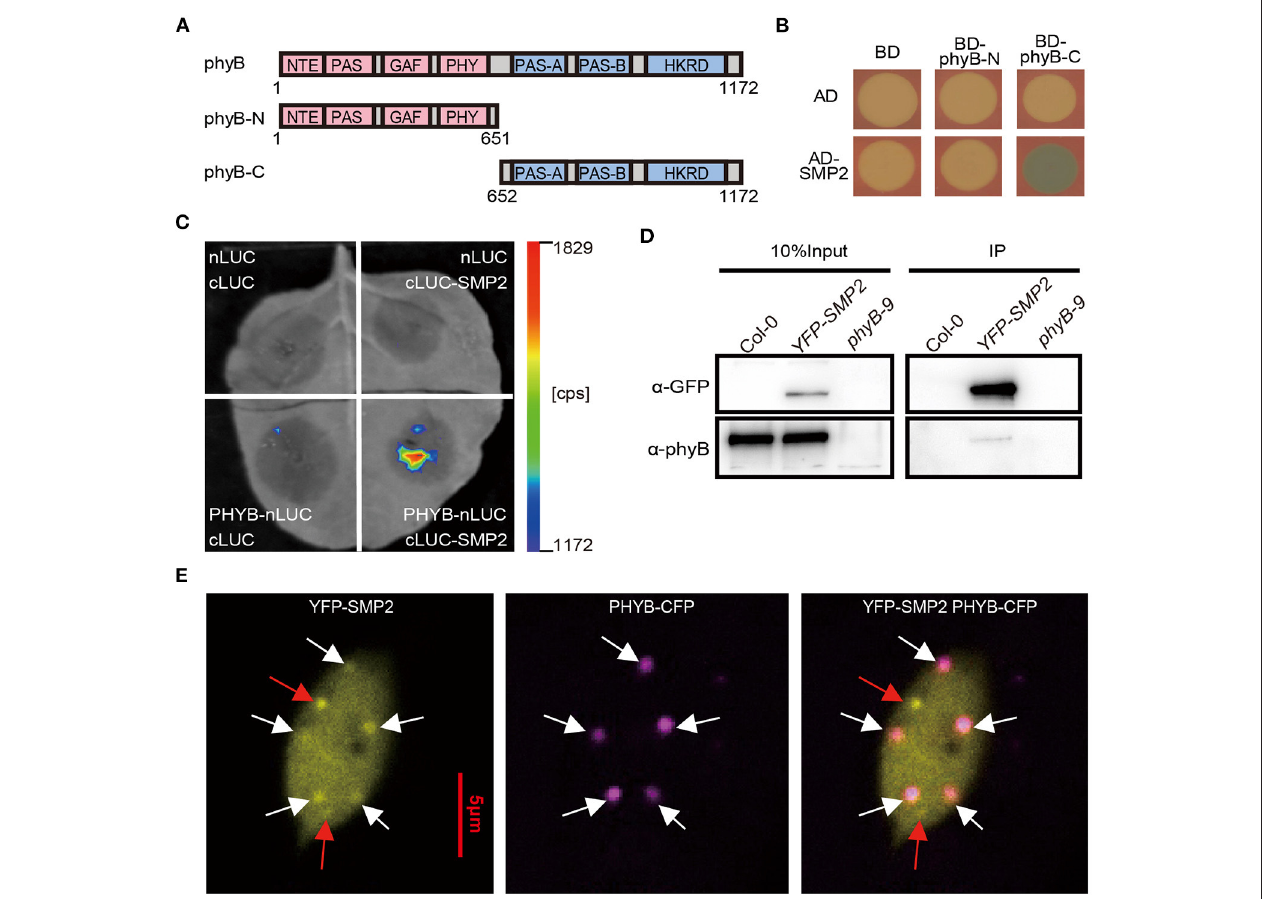
FIGURE 1 | phyB physically interacts with SMP2 in vitro and in vivo . (A) Schematic diagram of phyB fragments. Numbers indicate the amino acid positions in phyB protein. (B) The interaction of SMP2 and phyB in yeast. AD, activation domain; BD, DNA-binding domain. (C) Firefly luciferase complementation imaging (LCI) assay showing interaction between phyB and SMP2 in tobacco leaf. nLUC, the N-terminal fragment of firefly luciferase (LUC); cLUC, the C-terminal fragment of LUC. Full-length phyB and SMP2 were fused to the nLUC and cLUC, respectively. (D) Co-IP assay showing the association between SMP2 and phyB. Seedlings grown in the dark were transferred to red light (145 µ mol/m 2 · s) for 1h. YFP-SMP2 proteins were pulled down with GFP-trap beads. α -GFP, anti-GFP antibody; α -phyB, anti-phyB antibody. (E) Colocalization analysis of SMP2 and phyB in vivo . Transgenic plants co-expressing YFP-SMP2 and phyB-CFP were grown in continuous red light (145 µ mol/m 2 · s) for 5 days. The images of nucleus came from a hypocotyl cell. YFP-SMP2 fusion proteins were excited by laser at 514nm, and the emitted fluorescence signaling was collected from 519nm to 620nm; phyB-CFP were excited by laser at 405nm, and the emitted fluorescence was collected from 410nm to 513nm. Scale bar, 5 µ m. White arrowheads indicate SMP2 and phyB colocalized in photobodies; Red arrowheads indicate the SMP2-specific nuclear